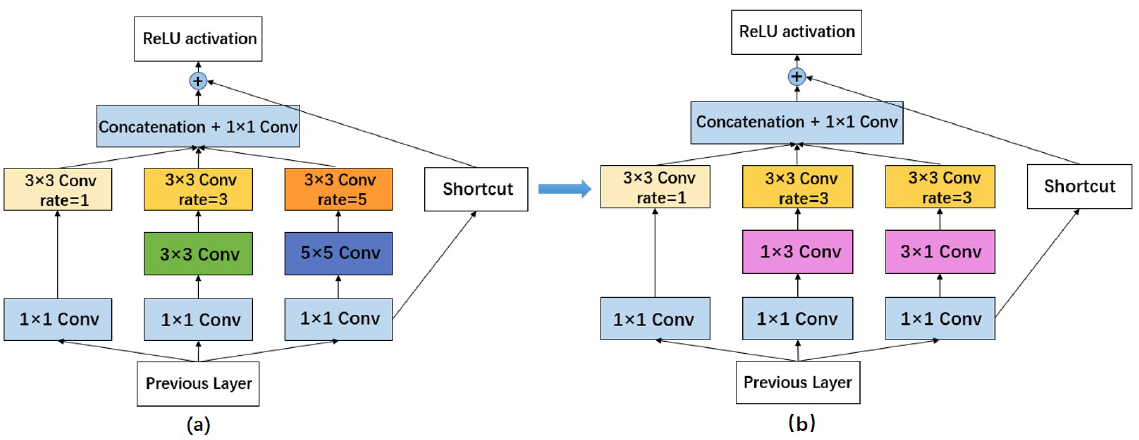
Figure 3. The architecture of RFB and RFB_sim. ( a ) The structure of RFB; ( b ) The architecture of